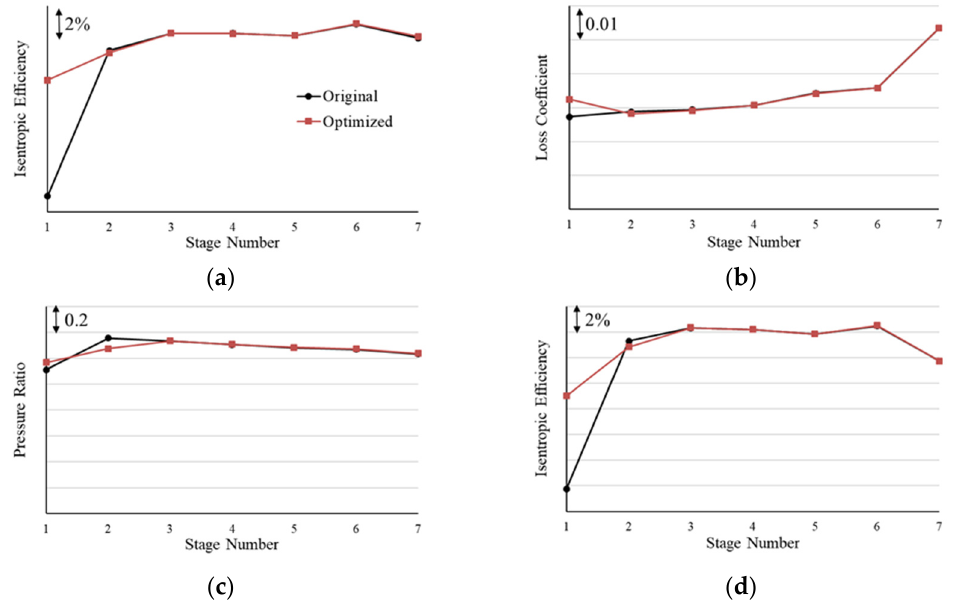
Figure 12. Performance changes of stages and blades during VGV1 adjustment. ( a ) Efficiency of rotors; ( b ) loss of stators; ( c ) pressure ratio of stages; ( d ) efficiency of stages.